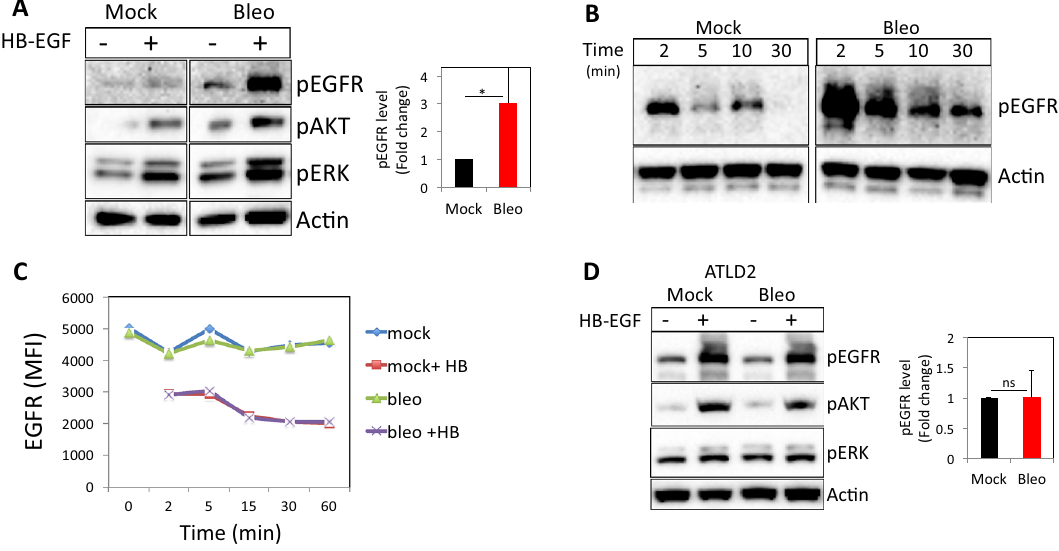
Figure 1. DNA damage enhances ligand-induced EGFR phosphorylation and signaling. Normal human dermal fibroblasts (HF) were either left untreated or treated with bleomycin for 30 min, followed by extensive washing and subsequent exposure to HB-EGF (10 ng/ml). After 5 min ( A ) or at indicated time points ( B ), cells were lysed. Western blot analyses were performed on cell extracts using antibodies to phosphorylated EGFR (Y1173), phosphorylated AKT, and ERK. Anti-β-actin immunoblotting revealed relative amounts of protein in each lane. ( C ) HF were treated as above and at the indicated time points cells were collected and immune-stained for cell surface expression of EGFR. MFI: Median fluorescent intensity. ( D ) Fibroblasts from an ATLD patient (ATLD2) were treated and analyzed as in ( A ). pEGFR signal intensities were quantified and normalized to actin signal (loading control). The level of EGFR phosphorylation in response to HB-EGF treatment in bleomycin treated cells as compared to that of mock-treated cells (set as 1) are shown ( A : n = 9; D : n = 4). Representative results of at least three independent experiments are shown. *p < 0.05; ns: